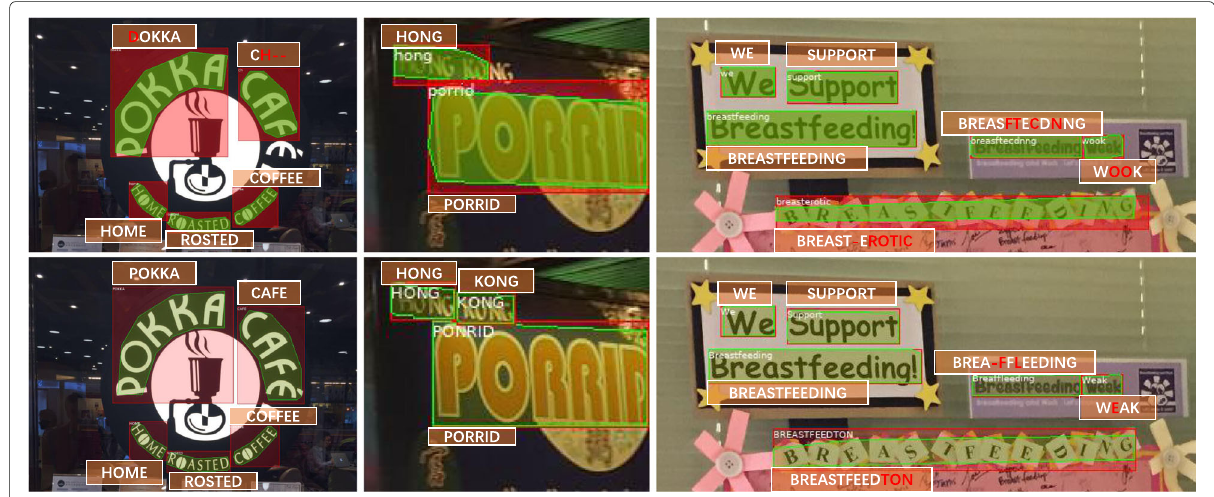
Fig. 5 Qualitative recognition results of the “ e2e-baseline ” and our text spotting model